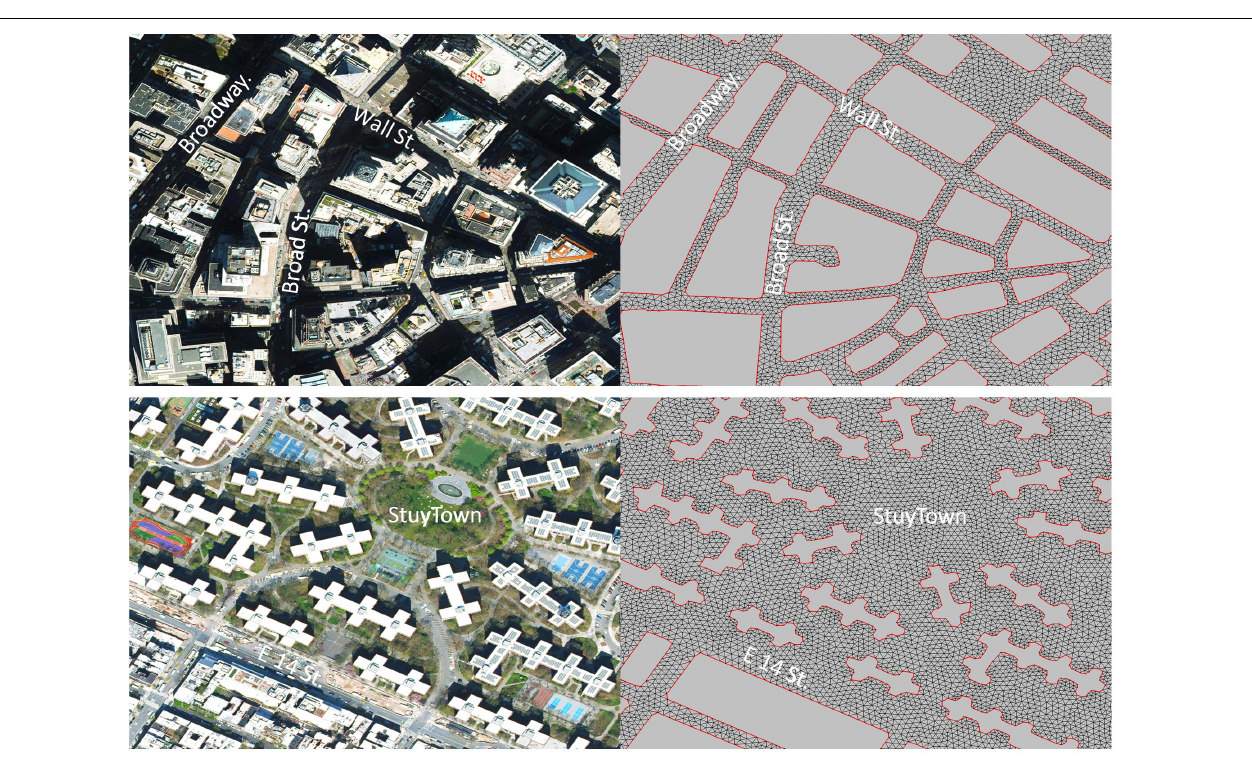
two-dimensional wave action balance equation to calculate the wave action density and the phase-averaged wave